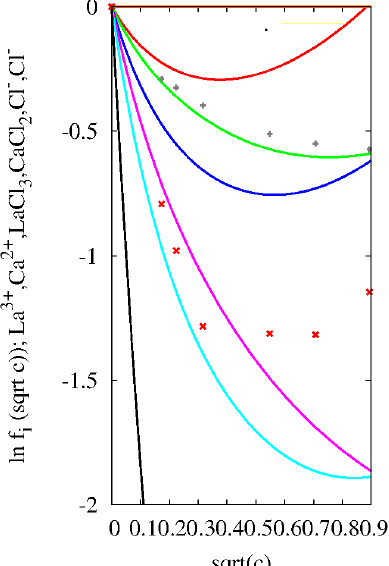
Figure 3. We show the activity coefficients of several ions and electrolytes. From above: Cl in CaCl 2 (red) and Cl in LaCl 3 (green), CaCl 2 (blue), LaCl 3 (magenta), Ca 2 + (turquoise), La 3 + (black). The activities were calculated in the semi-chemical approach neglecting so far quadruples, what could be the reason for too low values for the activities of CaCl 2 and LaCl 3 , Ca 2 + and La 3 + . The points denote data measured by Wilczek-Vera et al. [34] for Cl − and La 3 + in LaCl 3